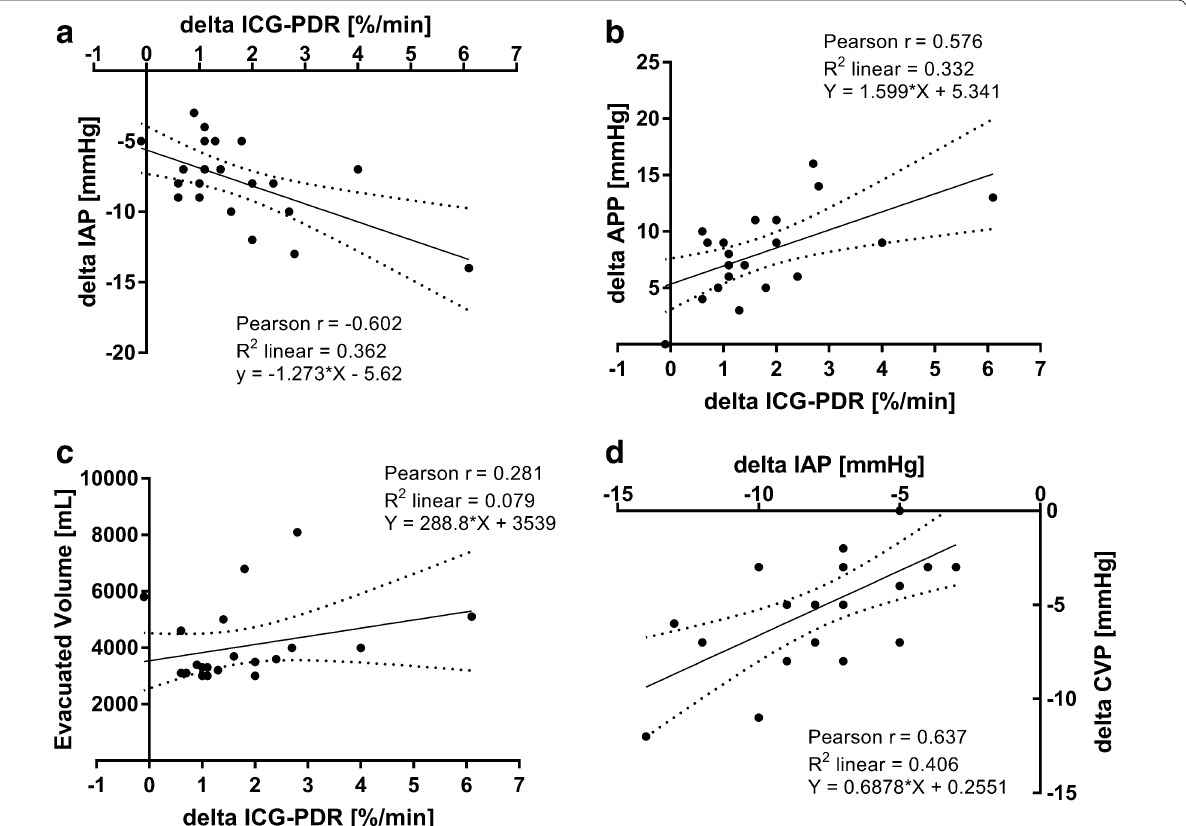
Fig. 4 Pearson correlations and regression plots of changes caused by paracentesis per patient ( n delta ICG‑PDR correlated with delta APP. c delta ICG‑PDR correlated with evacuated volume. d delta IAP correlated with delta